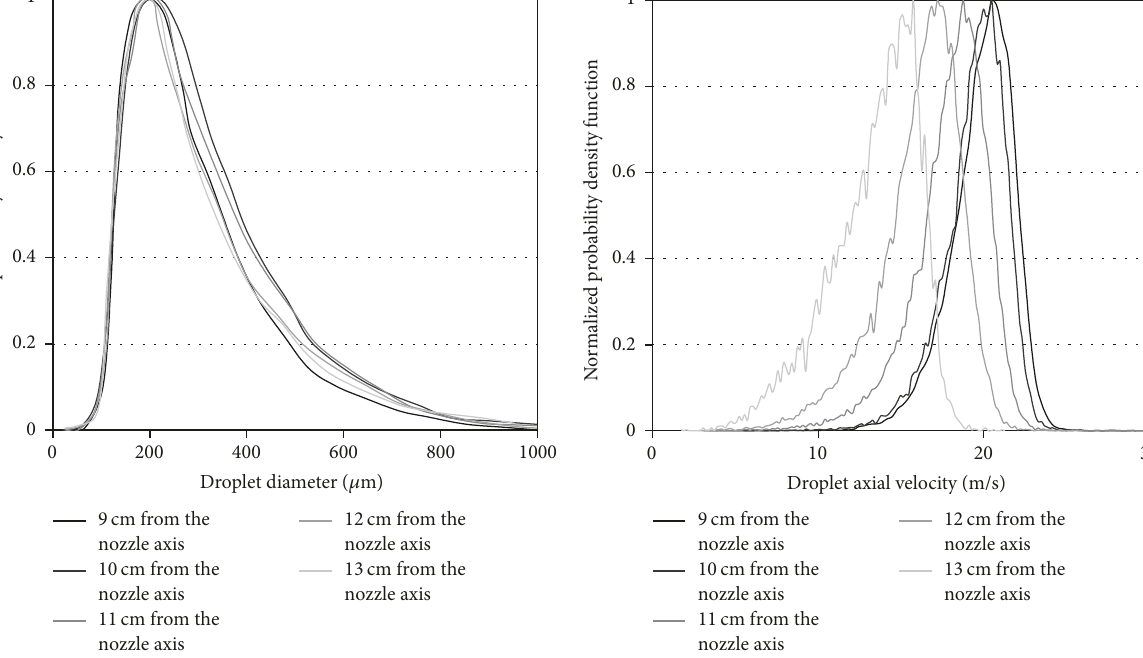
Figure 32: Experimental droplet diameter and droplet axial velocity distributions at 20cm from the nozzle, presented for different distances from the nozzle